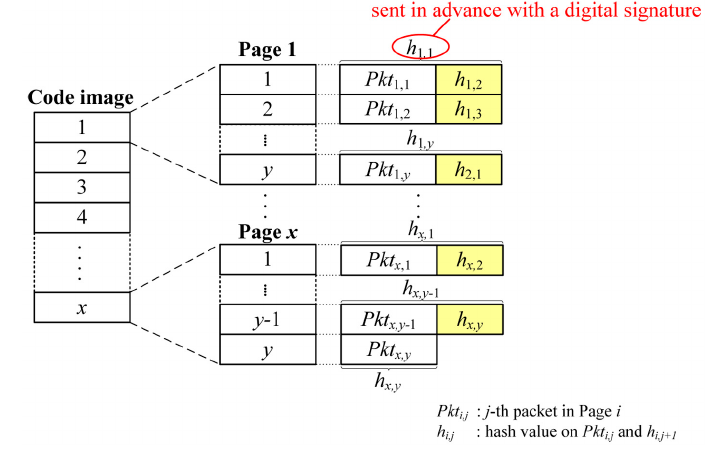
Figure 2. An example of Secure Deluge.